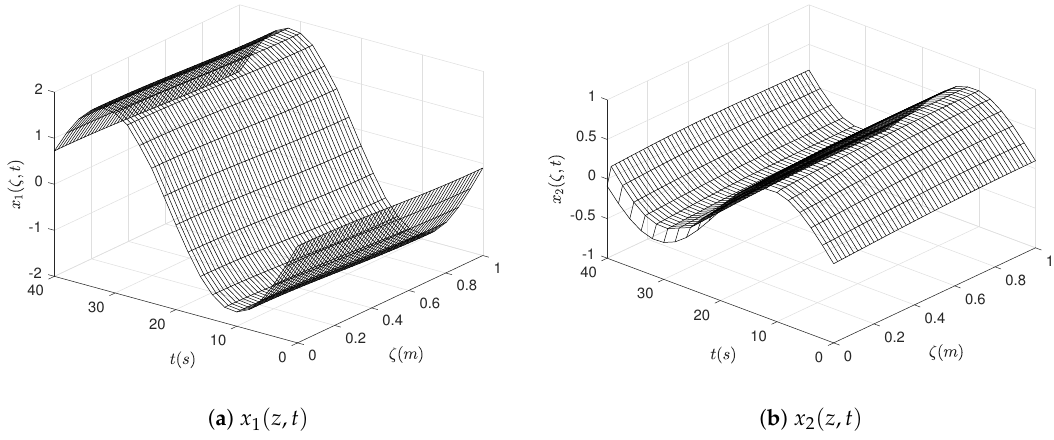
Figure 11. State evolution of the filtered wave system.